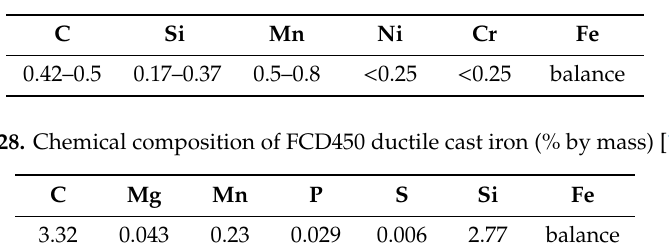
Table 27. Chemical composition of 1045 carbon steel (% by weight) [2].